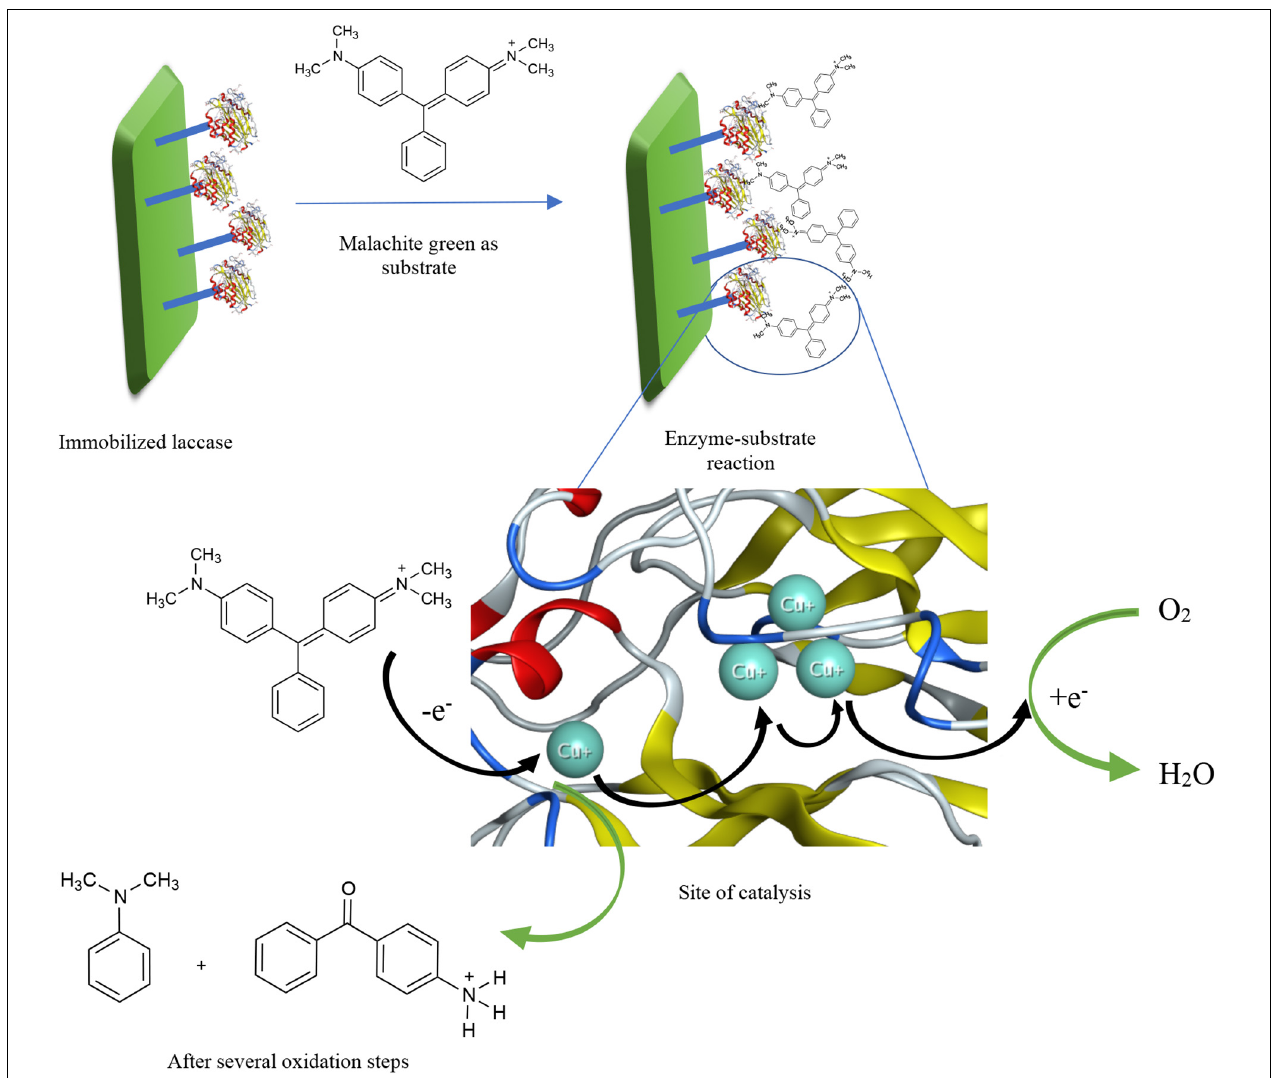
FIGURE 1 | A proposed mechanism of dye degradation by immobilized laccase with the aid of the crystal structure of laccase from Thermus thermophilus HB27 (PDB code: